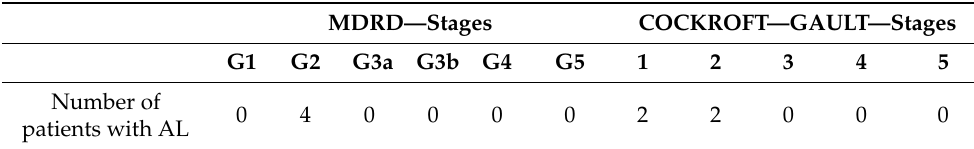
Table 13. MDRD staging for AL positive